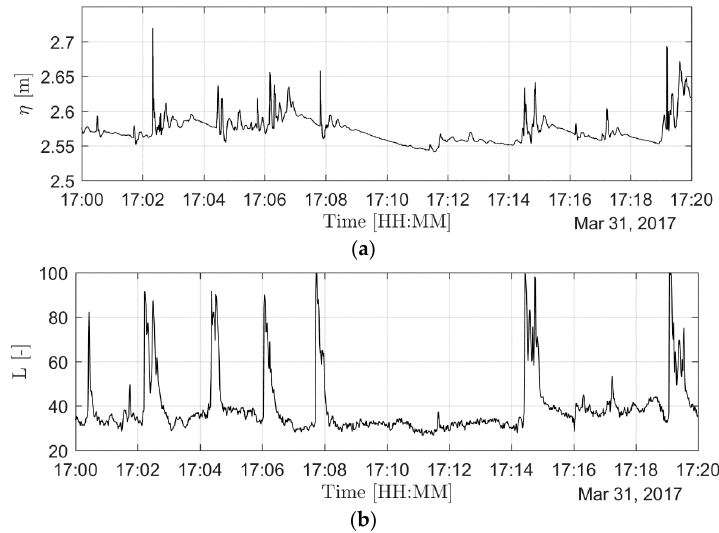
Figure 9. Comparison of ( a ) water surface elevation time series derived from the pressure transducer data ( η ), and ( b ) the pixel lightness metric (L) from the pixel at the transducer deployment location obtained from the rectified camera imagery from 31 March 2017. Water surface elevations are shown relative to the PT location at the bottom of the pool on the rock platform that had a depth of ~2.5 m. The PT location shown here was the northeast PT of the two deployed on 29 March 2017 (319,261 m E, 6,214,520 m N). See Figure 2 for location.